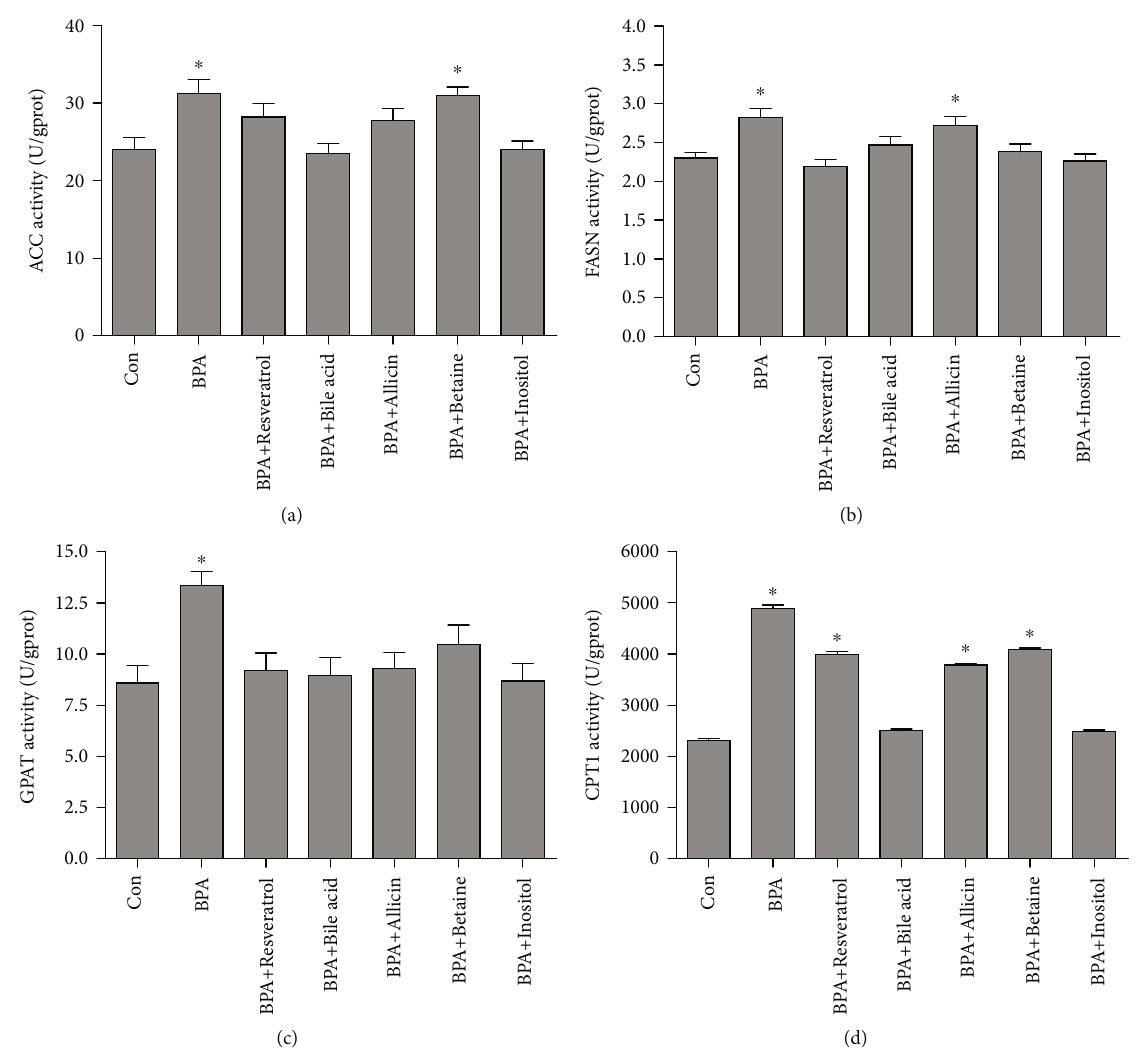
Figure 4: Lipid metabolism enzyme activities in rare minnow liver following BPA and experimental additives treatment. (a) ACC; (b) FASN; (c) GPAT; (d) CPT1. All statistical data were expressed as mean ± SD ( n =3). ∗ stands for there is a signi fi cant di ff erence between the treatment groups and Con groups ( P < 0 : 05